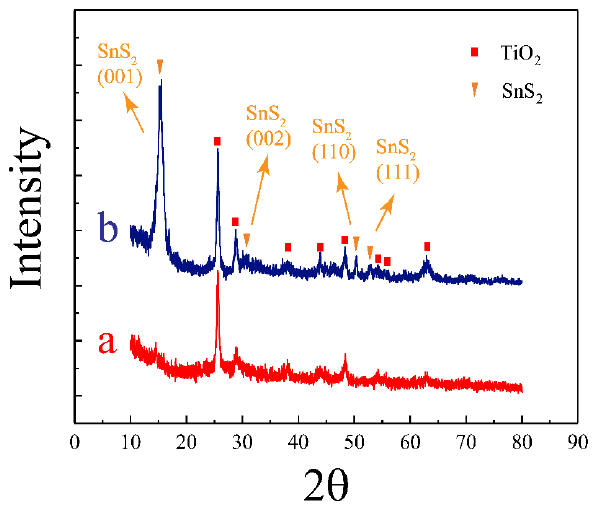
Figure 1. XRD patterns of ( a ) the TiO 2 belts and ( b ) the TiO 2 -SnS 2 nanostructure.